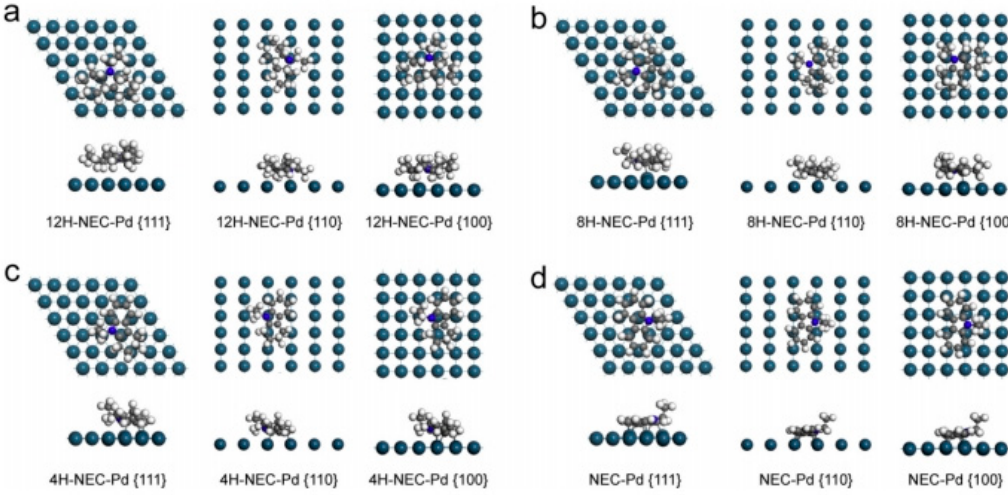
Figure 7. Top and side views of the optimized adsorption configurations of ( a ) 12H-NEC, ( b ) 8H-NEC, ( c ) 4H-NEC, and ( d ) NEC on Pd {111}, {110}, and {100} surfaces.